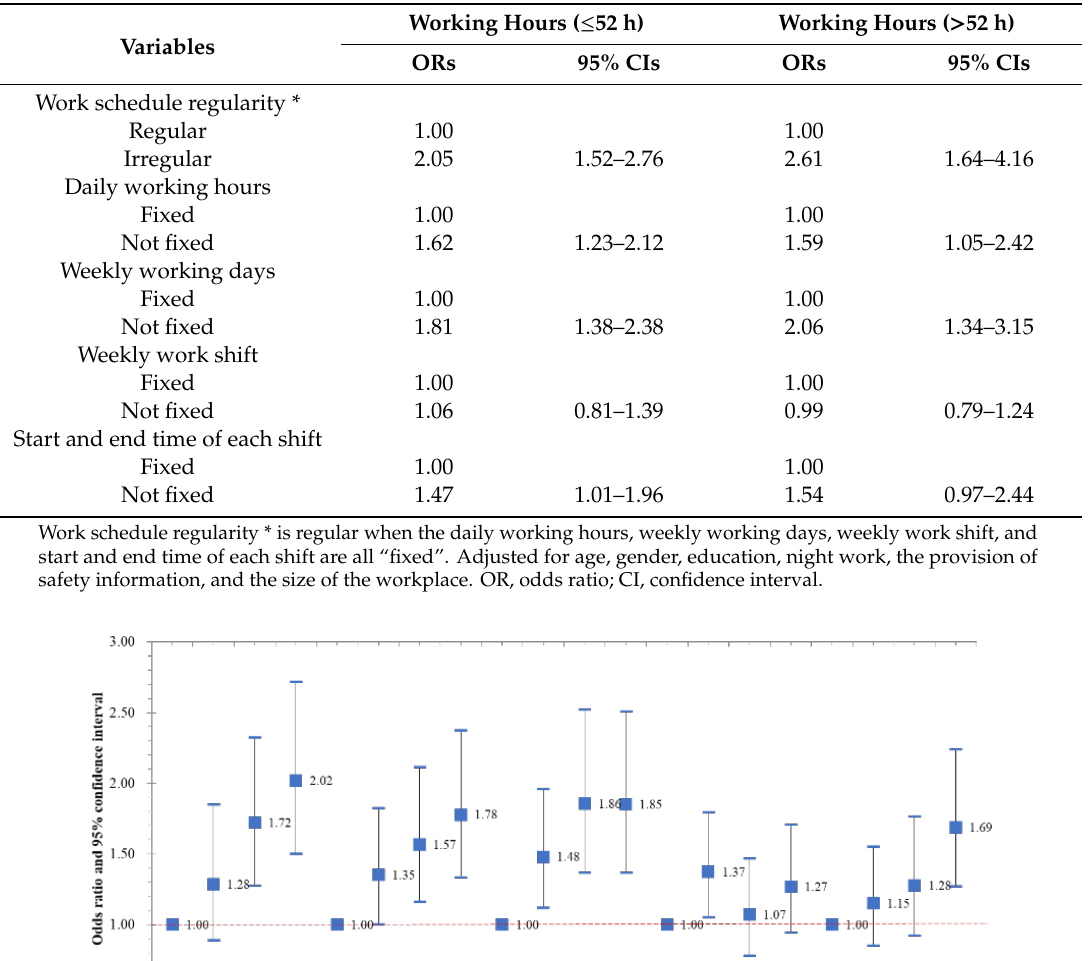
Table 3. Odds ratio and 95% confidence intervals for work-related injury in stratification analysis for working hours.